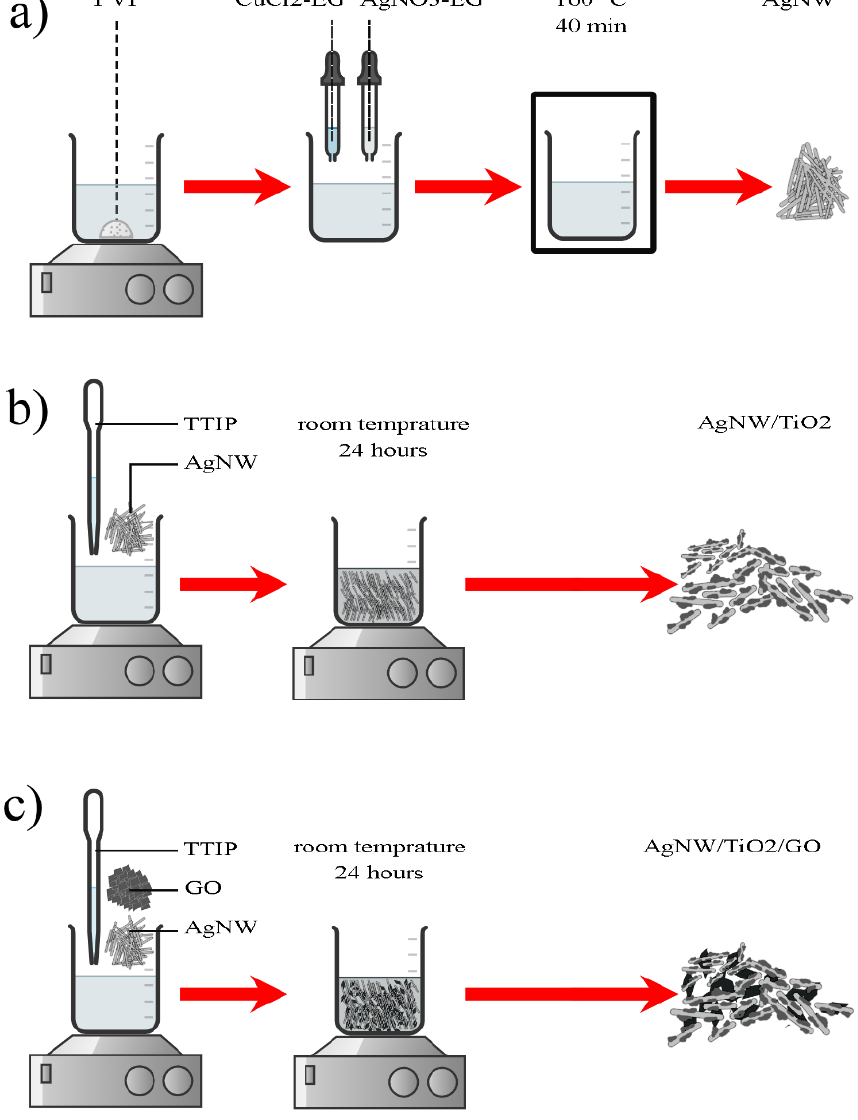
Figure 1. A schematic diagram describing the synthesis process of ( a ) AgNW, ( b ) AgNW/TiO 2 , and ( c ) AgNW/TiO 2 /GO samples.